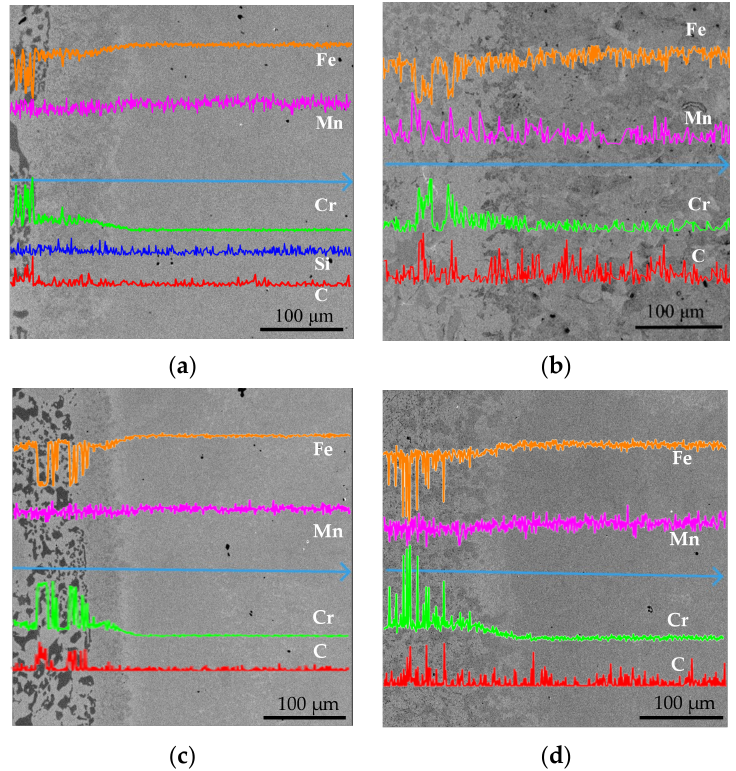
Figure 9. EDS images and element line analysis results of specimens for different pouring time intervals: ( a ) 35 s, ( b ) 40 s, ( c ) 45 s, and ( d ) 50